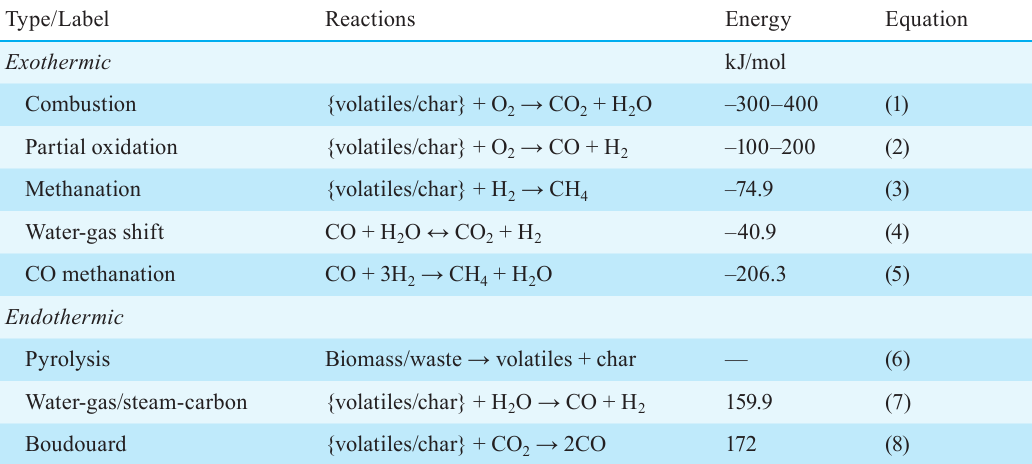
Table 1 Main reactions during the thermochemical transformation of solid